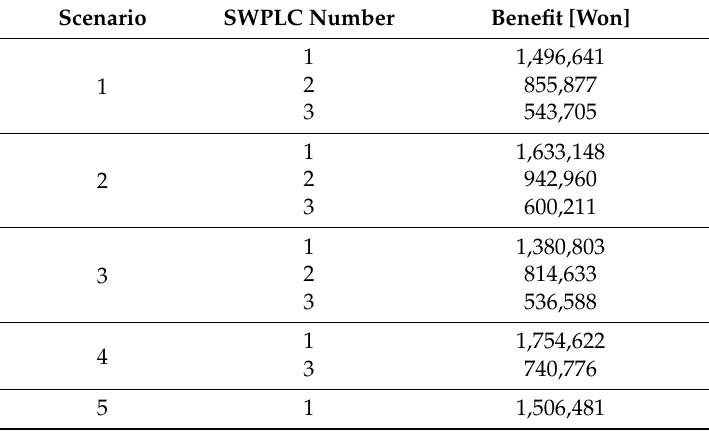
Table 3. Simulation parameter and applied value.